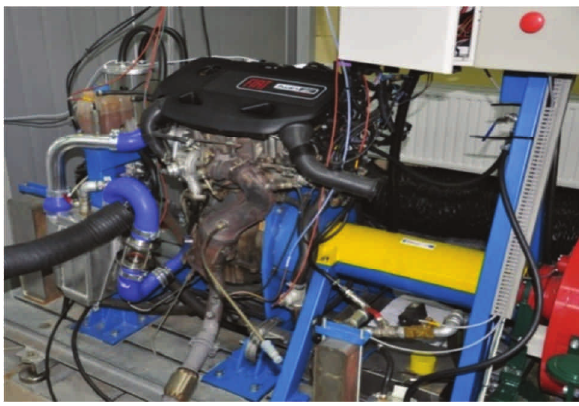
Fig. 2. Test bench of the Fiat 0,9 TwinAir engine